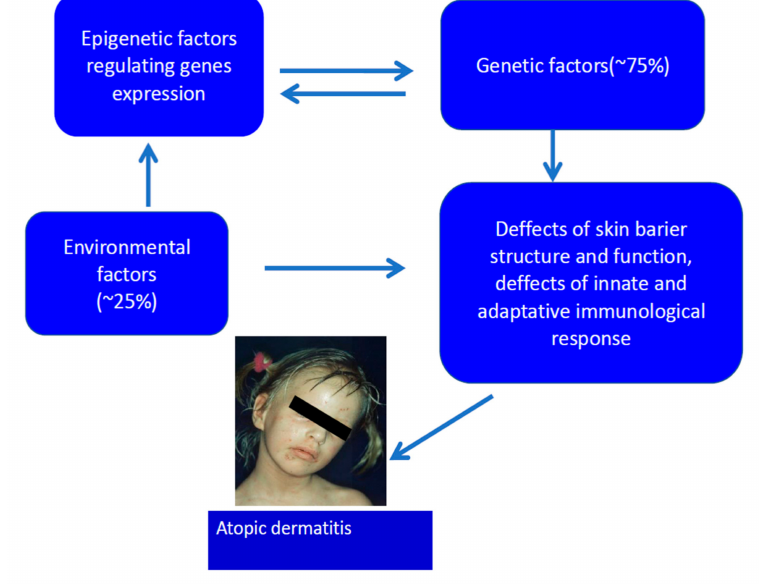
Figure 1. Etiology of atopic